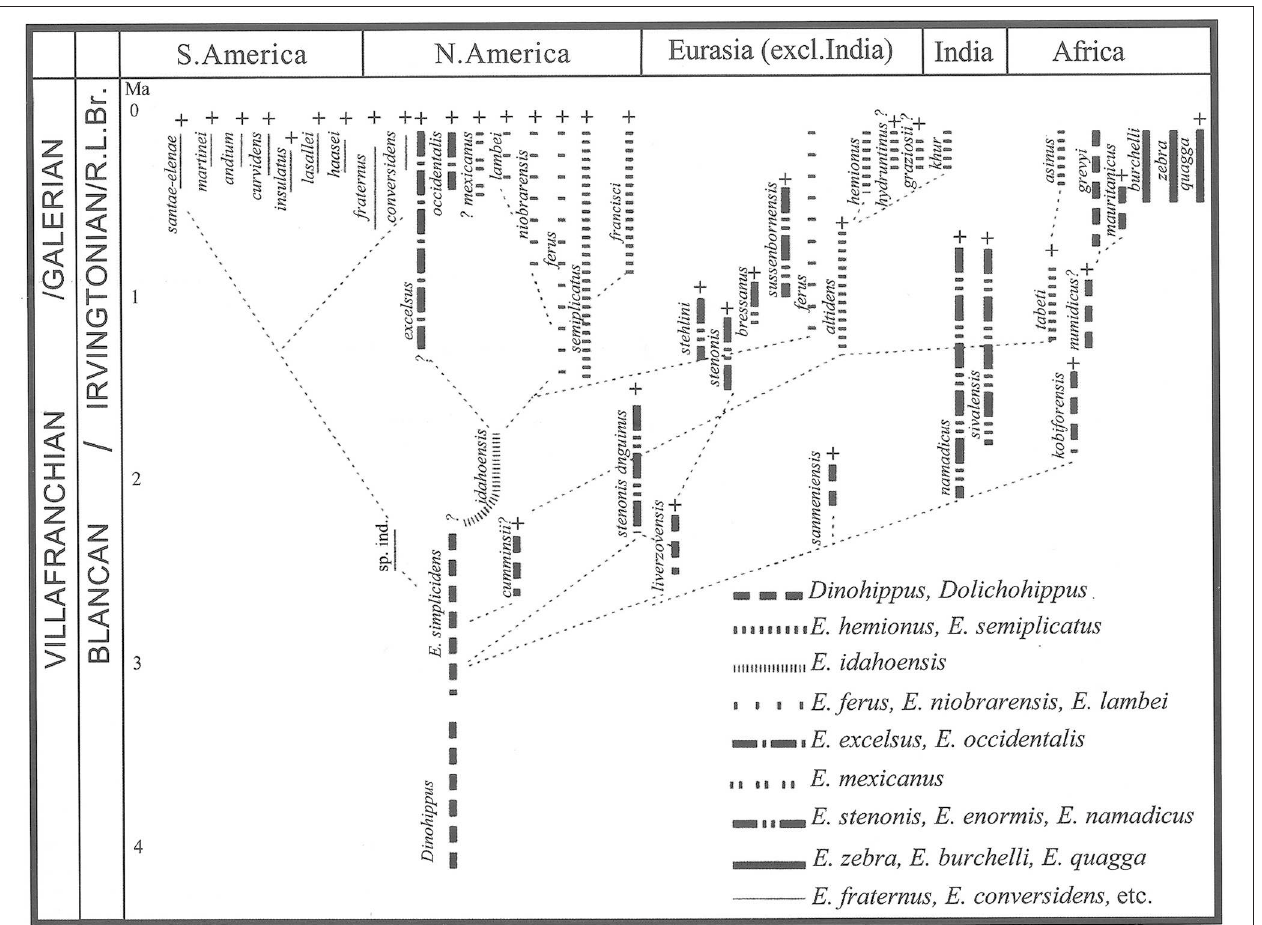
FIGURE 13 | Phylogeny of the genus Equus with species geographical and stratigraphical distribution from Azzaroli